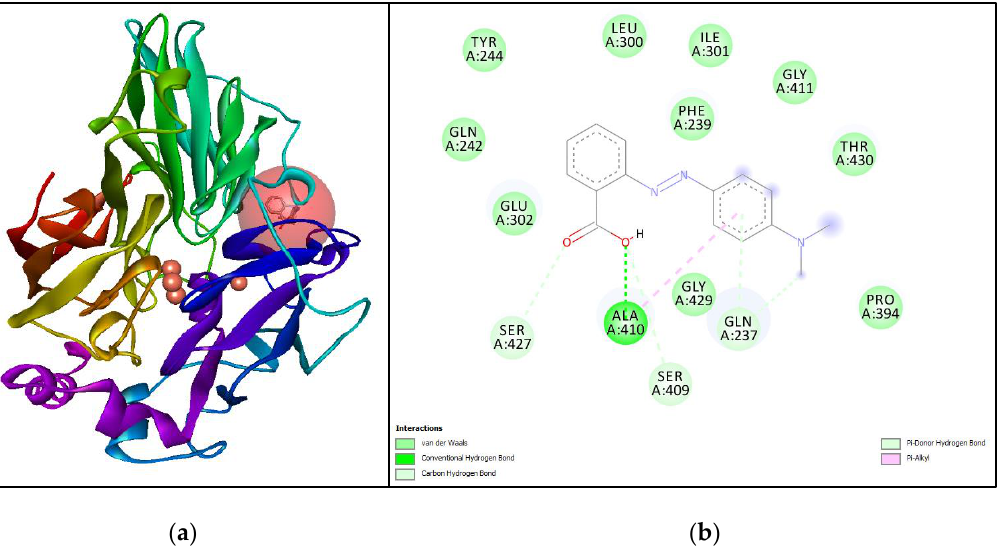
Figure 7. Molecular docking of methyl red and laccase; ( a ) the substrate is presented as stick and balls and the enzyme as solid ribbon and ( b ) two-dimensional diagram, the close aminoacid residues are presented in green, dashed lines represent intermolecular interactions of different origin (hydrogen bonds—green lines; π -alkyl—pink line; van der Waals interactions and other hydrophobic forces—light green lines).